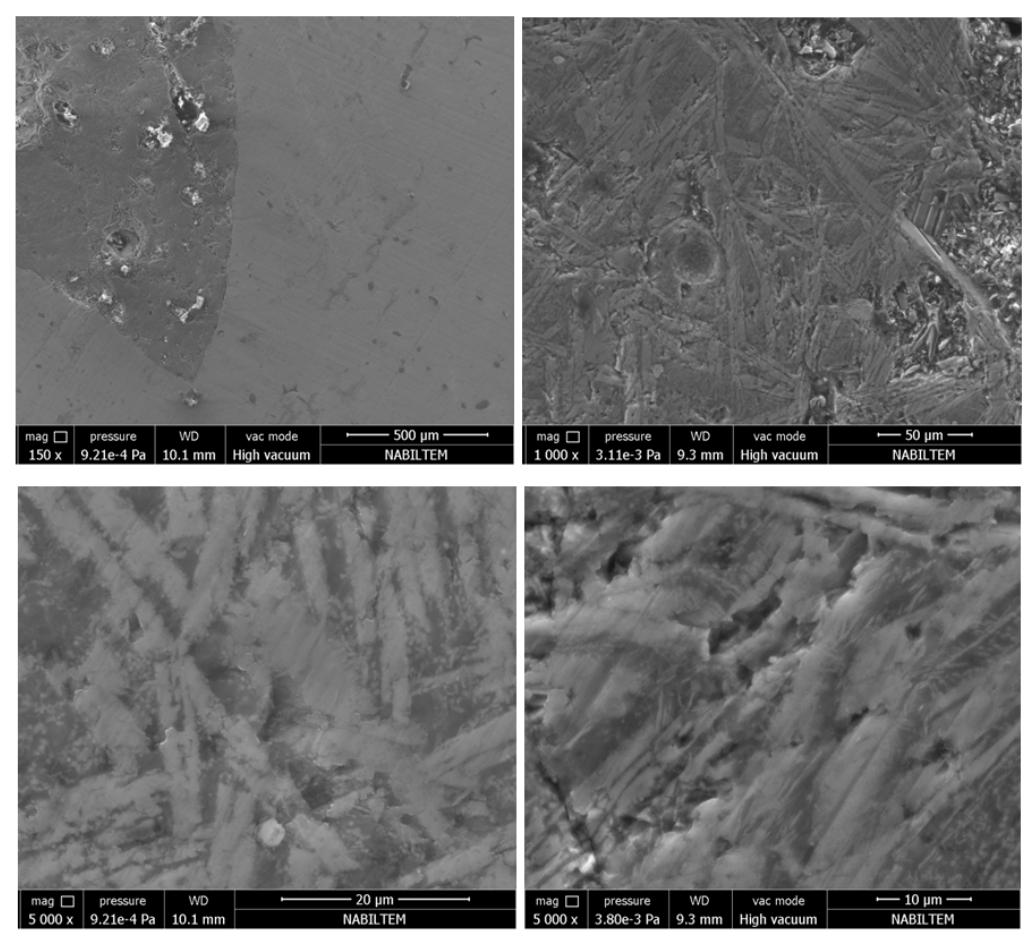
Figure 8. Scanning electron microscope test of the electric arc welded rod.